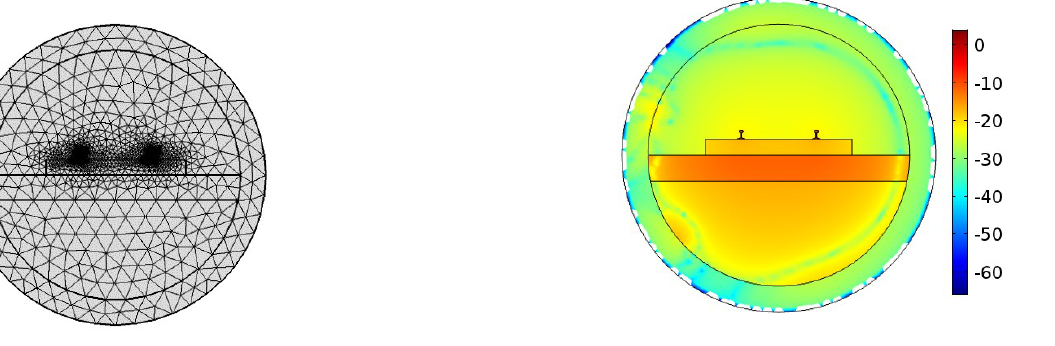
Fig. 8. Electromagnetic loss of layered earth layered earth mutual impedance